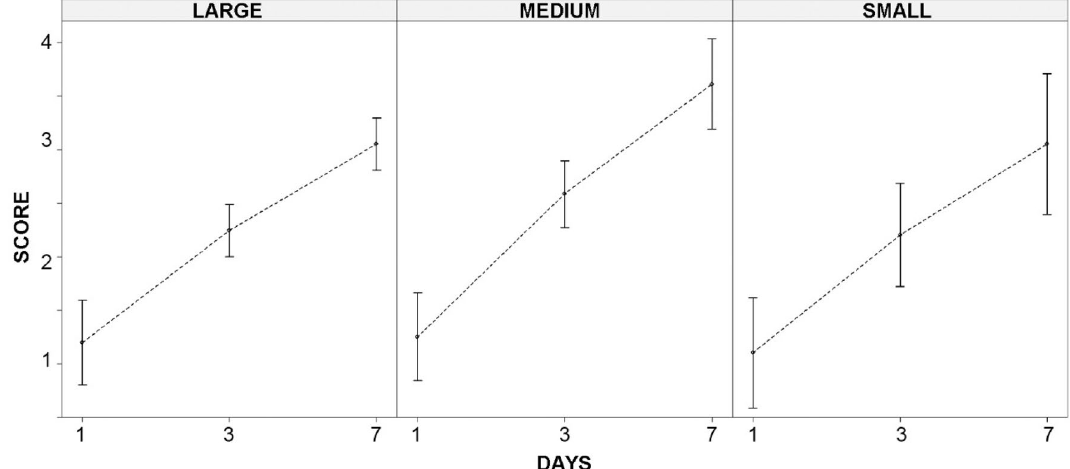
Figure 2. Decomposition scores of three different bird-sizes (large—domestic hens, medium—pigeons, small—chicks of domestic hens) throughout the first week after fresh carcasses placement in the field (three sampling events at days 1, 3, and 7) on the islands of Lanzarote and Fuerteventura. The vertical bars show the average ± 95% confidence intervals of the data pooled for the two islands (the main effect of island, and the interactions between Island and the other two factors were not significant; see Table 3 for more